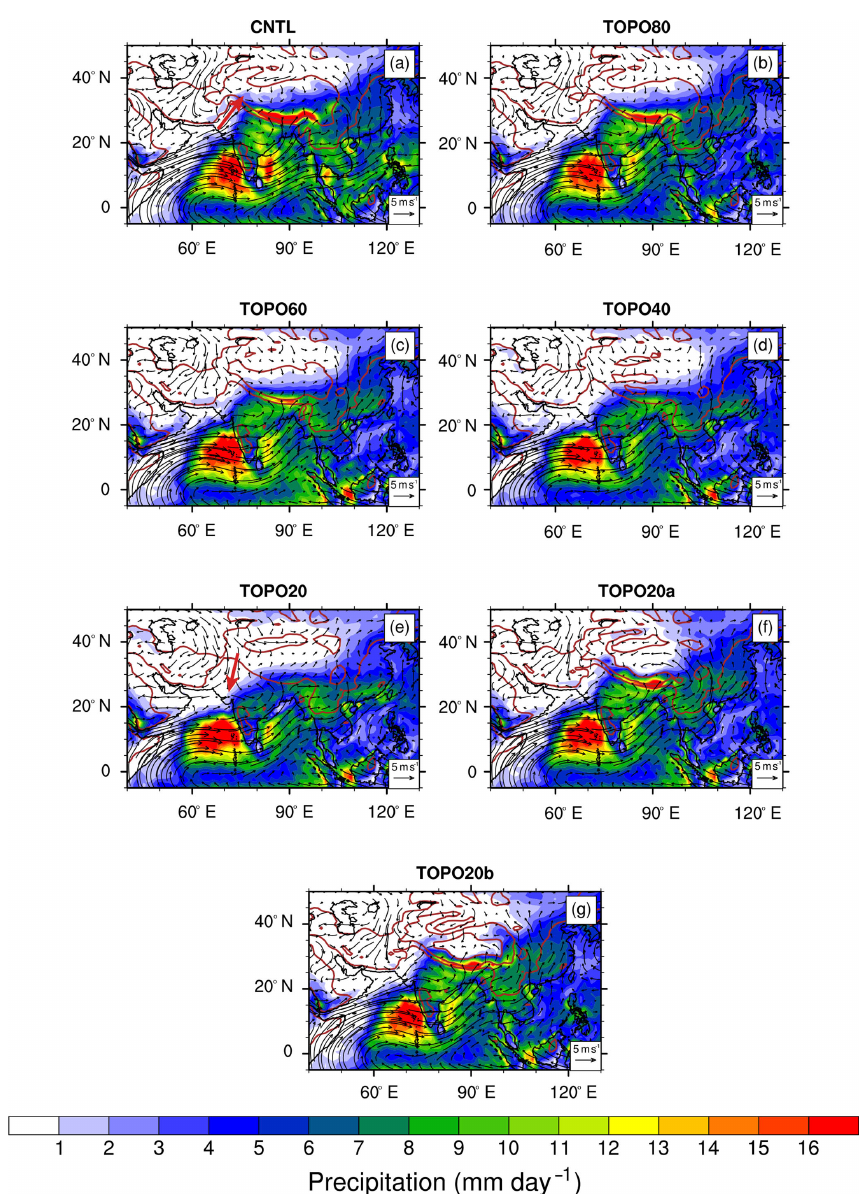
Figure 6. Summer (June–July–August) low-level (850hPa) wind (arrows) and precipitation (shaded) for the (a) CNTL, (b) TOPO80, (c) TOPO60, (d) TOPO40, (e) TOPO20, (f) TOPO20a, and (g) TOPO20b cases. Brown contour lines represent 500 and 2000m surface elevation contours in the Tibetan region. The red arrows on the western Himalayan slope in (a) and (e) show the wind direction reversal from CNTL to